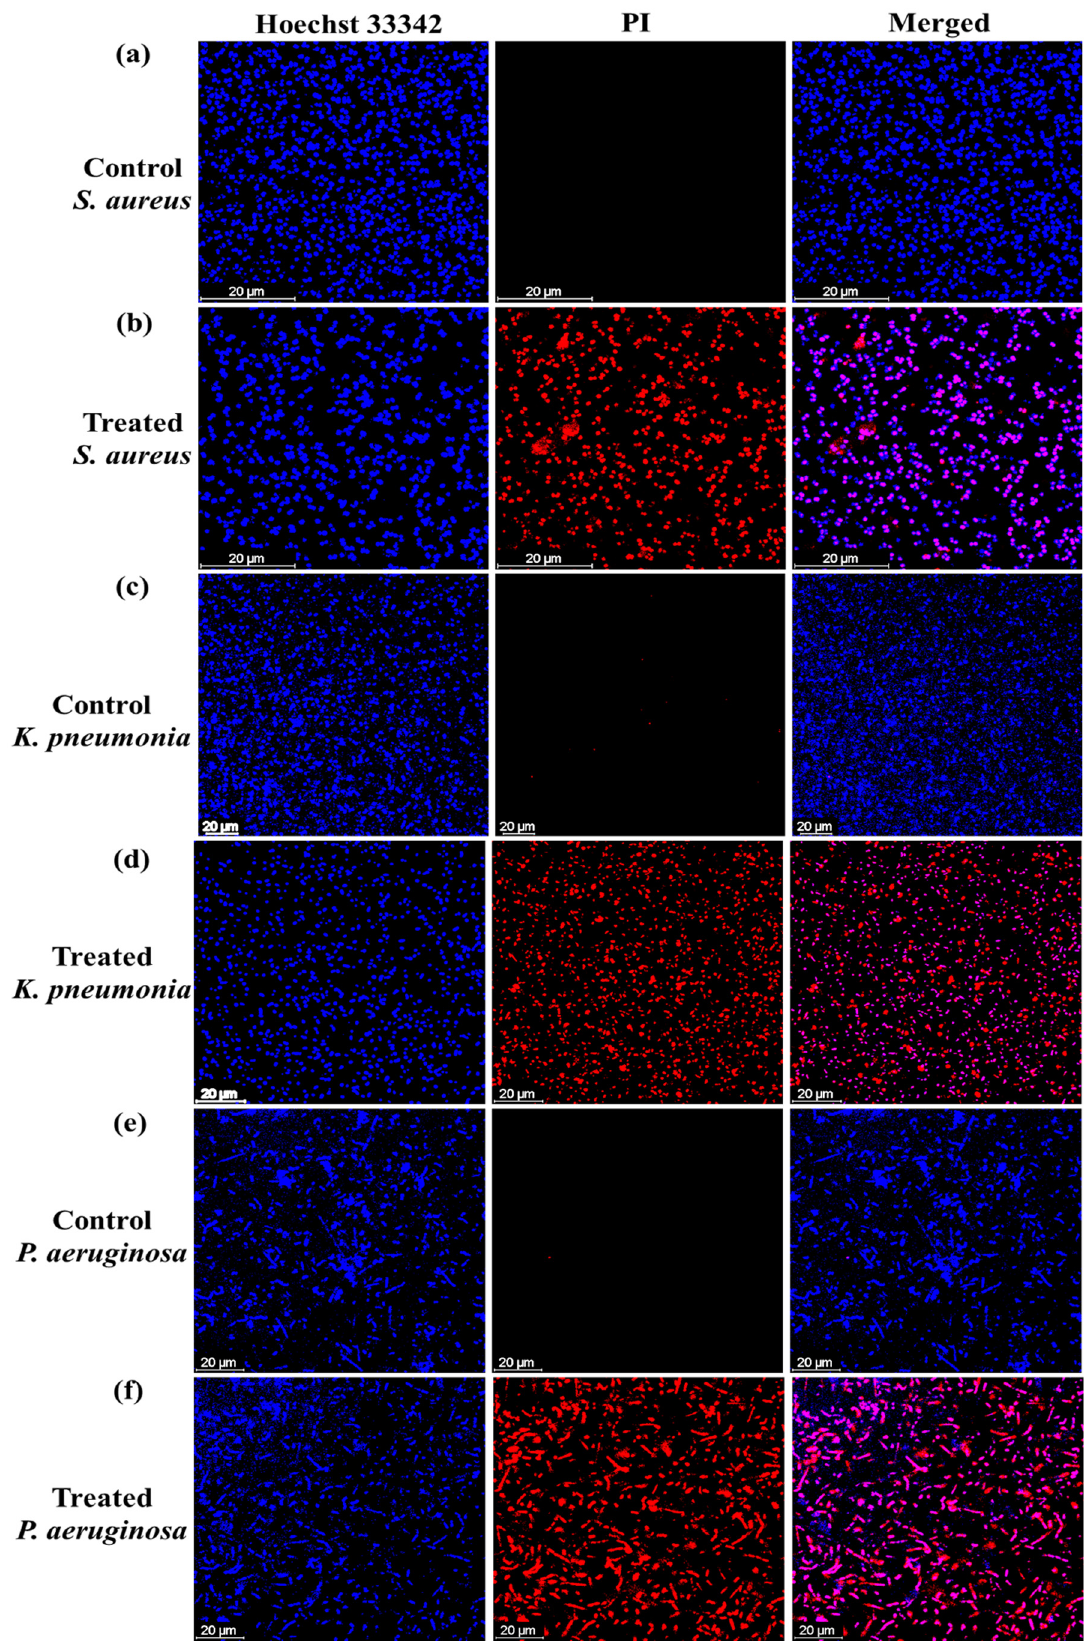
Figure 5. CLSM images of Live/dead bacteria. ( a , c , e ) control and ( b , d , f ) treated bacteria with green synthesized OE-Ag NPs.